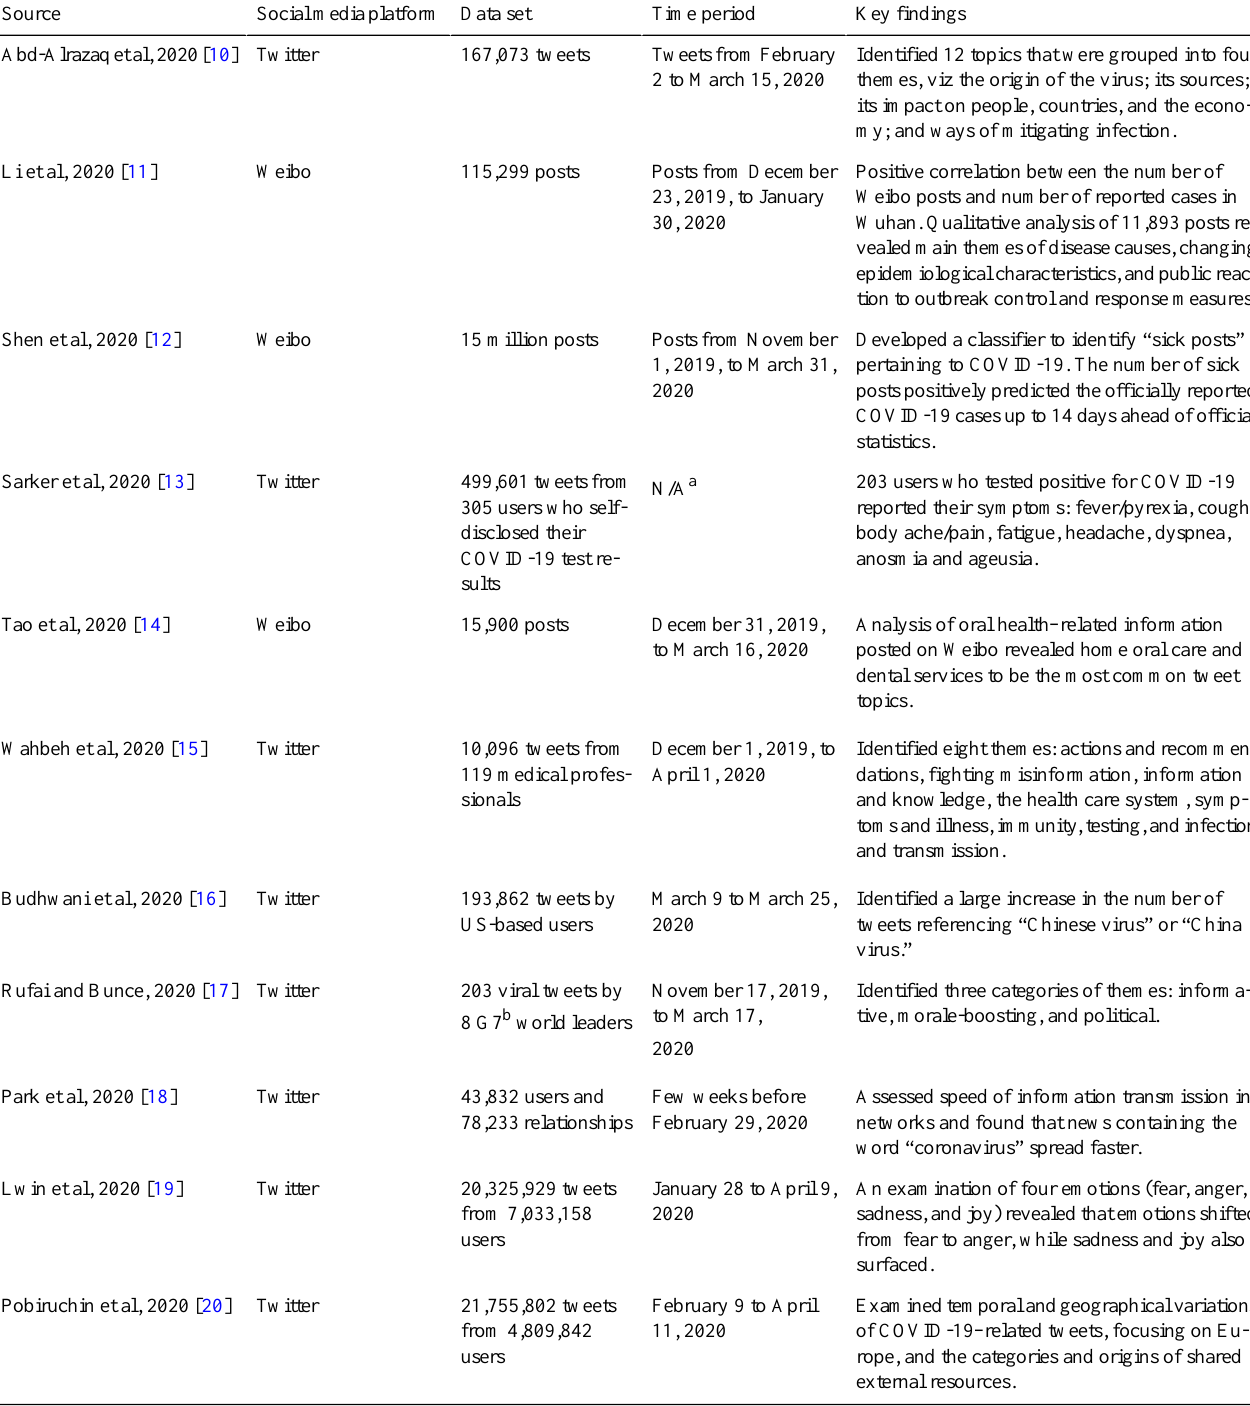
Table 1. Summary of key studies on the COVID-19 pandemic using social media data.